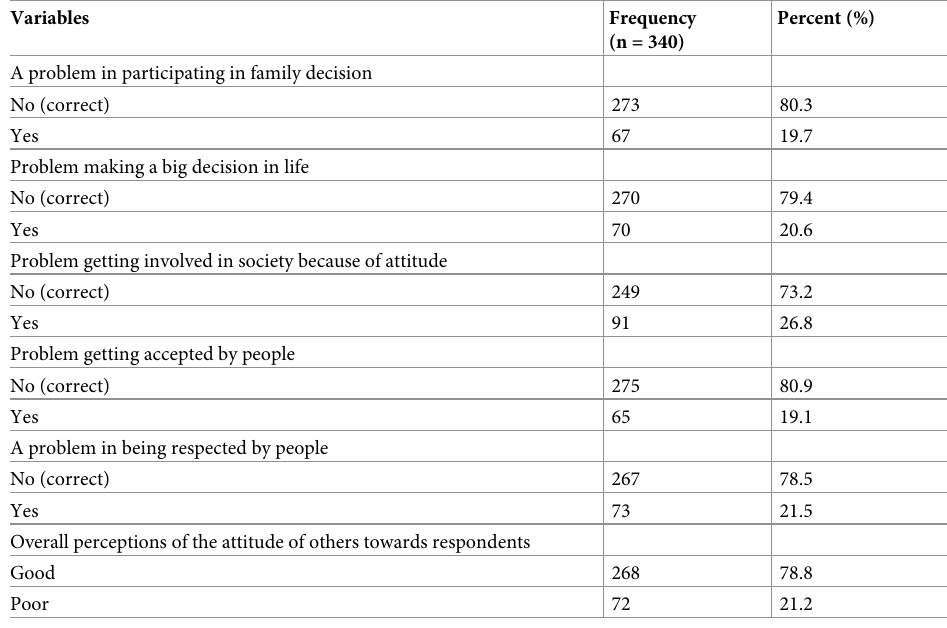
Table 3. Perception of the attitude of others towards respondents with